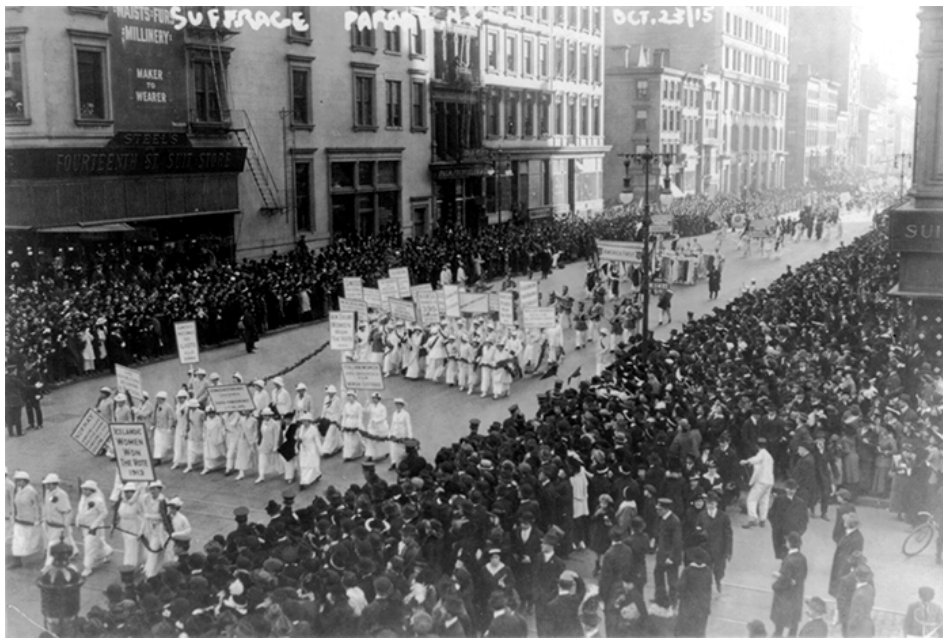
Figure 2. Women march for suffrage. 23 October 1915, New York City. Library of Congress.